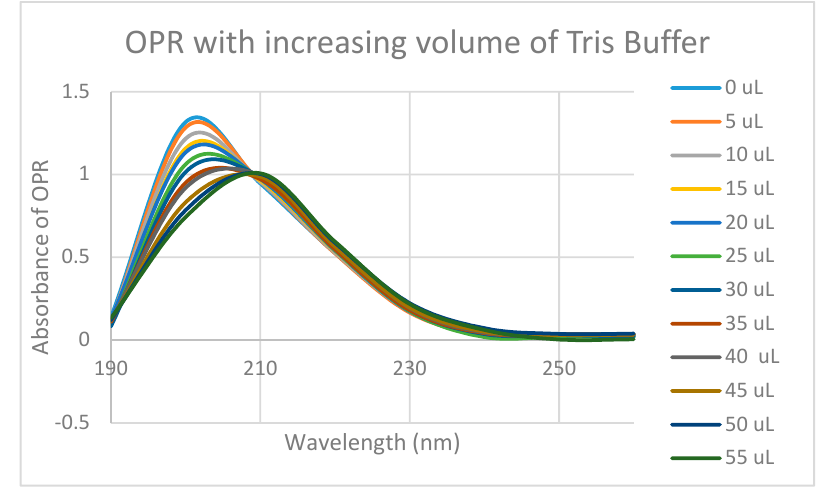
Figure 10. UV spectra of mu opioid receptor (OPR) with the same serial additions of Tris buffer in which the experiments illustrated in Figures 12–14, 16 and 17 were performed. Note that the absorbance at 210 nm does not change as a result of these additions, so 210 nm was used to analyze binding affinity due to addition of epinephrine, morphine and methionine-enkephalin in Figures 15 and 18. Binding affinity was also calculated at 200 nm by accounting for buffer effects, but as a result, the calculated binding constants are somewhat less reliable (see Table 3).